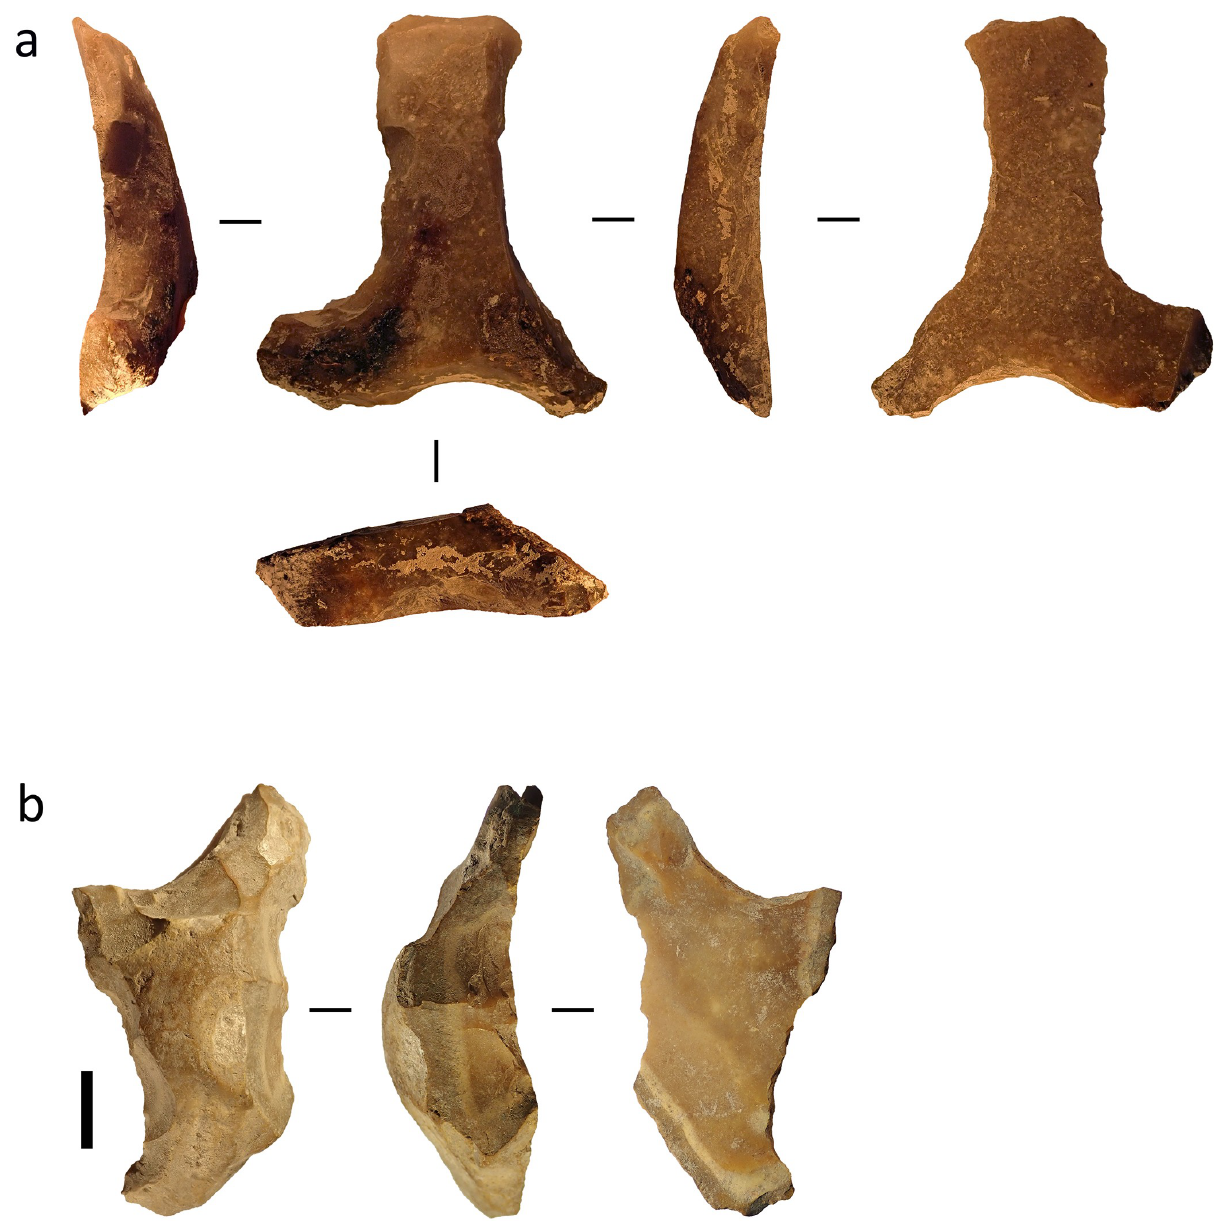
Fig 2. Heavily retouched flakes or ‘scrapers’ from Leang Panninge. (a) Artefact recovered from square S16T6, 182–202 cm below the surface. (b) Artefact recovered from square T17S6, 162–1720 cm below the surface. Scale bar = 1 cm.